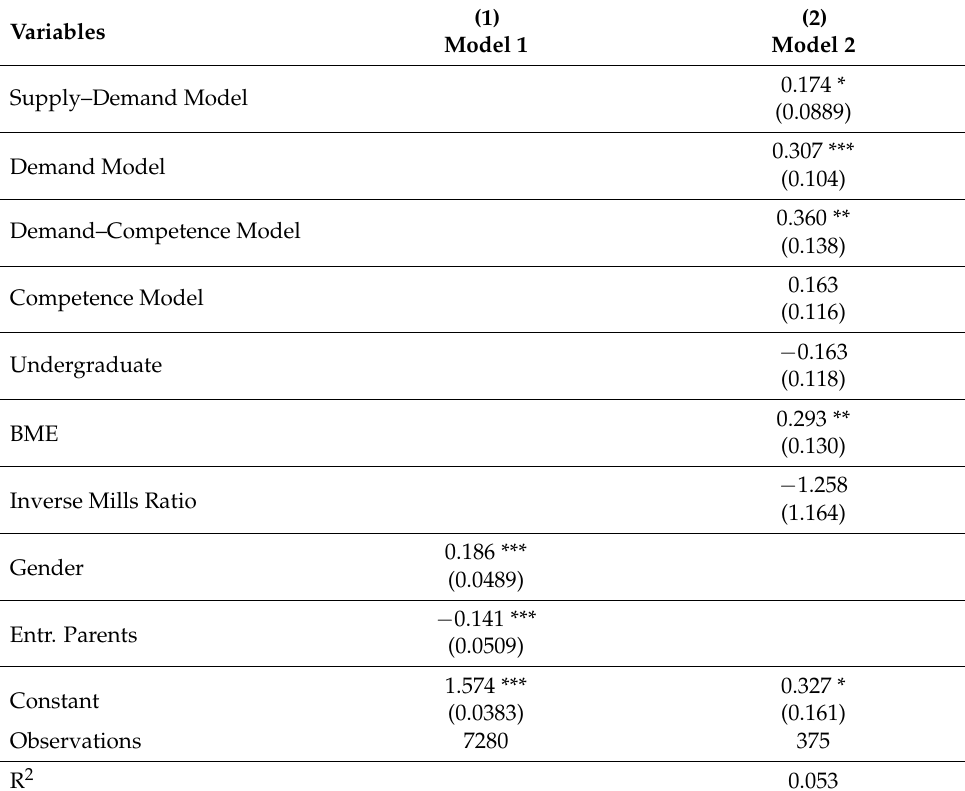
Table 10. Heckman two-step